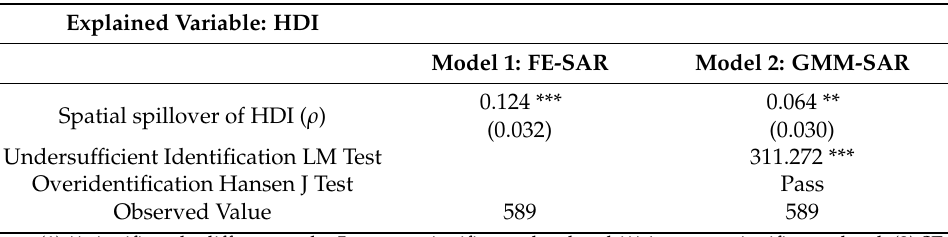
Table 2. Estimation Results of the Spatial Spillover Effect of HDI.